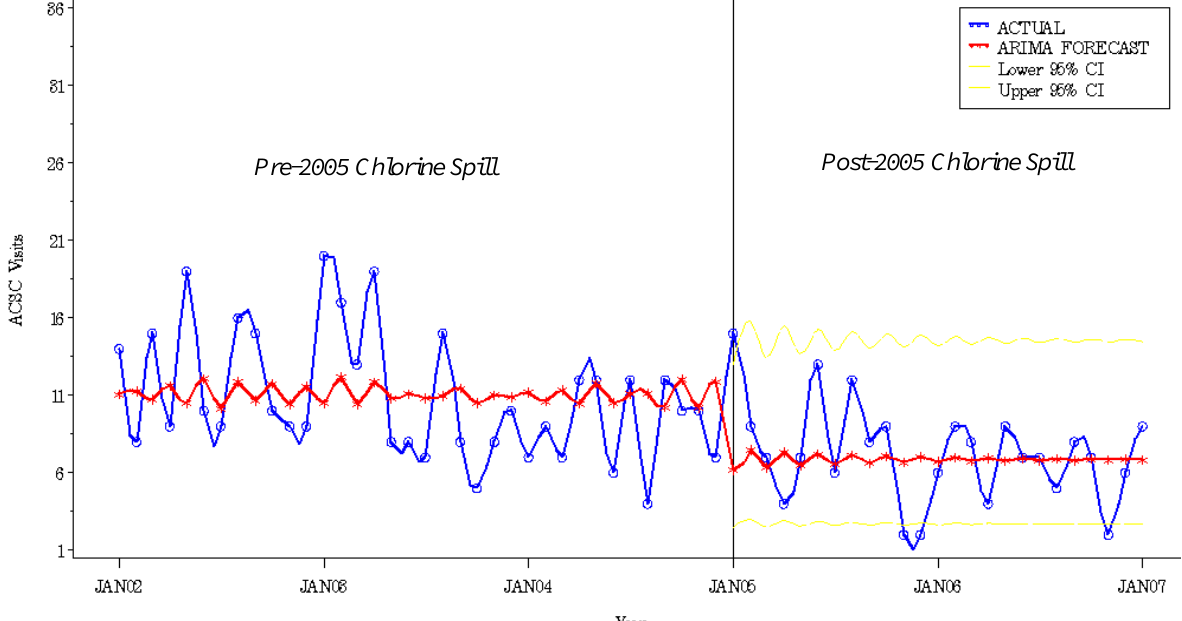
Figure 1. Model Actual vs. Predicted Plot of Ambulatory Care Sensitive Conditions ± with 95% Confidence Band for Direct Group: SC Medicaid Beneficiaries, 2002–2006.